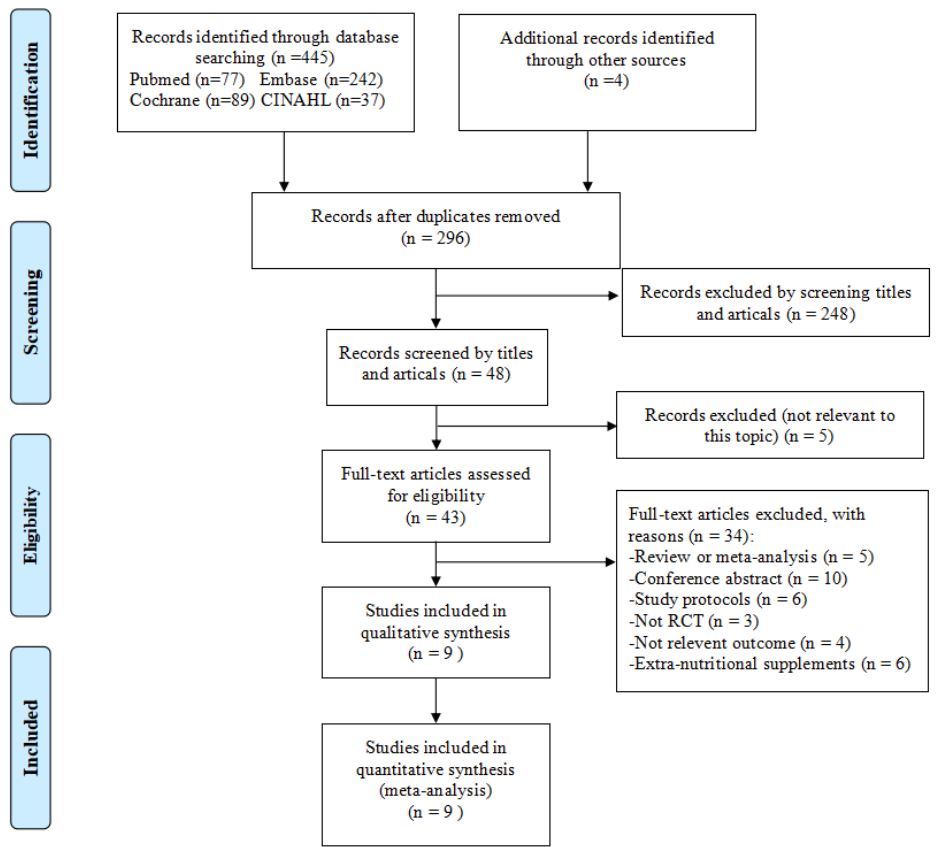
Figure 1. PRISMA flow chart showing the selection of articles.